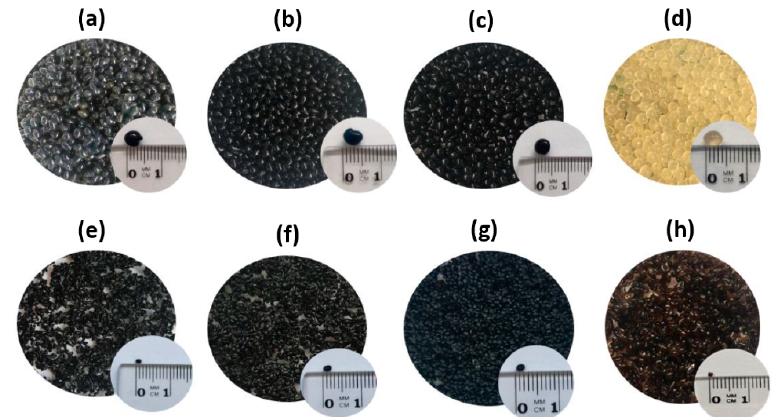
Figure 1. Pictures of prepared sorbents. Wet form: ( a ) S1, ( b ) S2, ( c ) S3, ( d ) S, and dry form: ( e ) S1, ( f ) S2, ( g ) S3, ( h ) S.